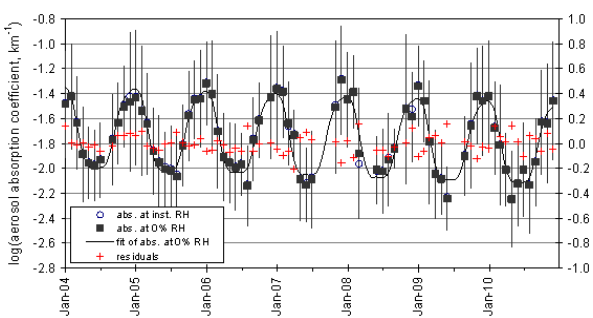
Figure 3. Variations in the aerosol absorption coefficient at 520nm at IPR: logarithm of the monthly mean values at instrumental RH (open circles), at 0% RH (squares), least mean square fit of the log- arithm of the monthly mean values at 0% RH (line), and residuals (crosses, right axis). Error bars show the standard deviation of the log of the monthly mean values at 0% RH.